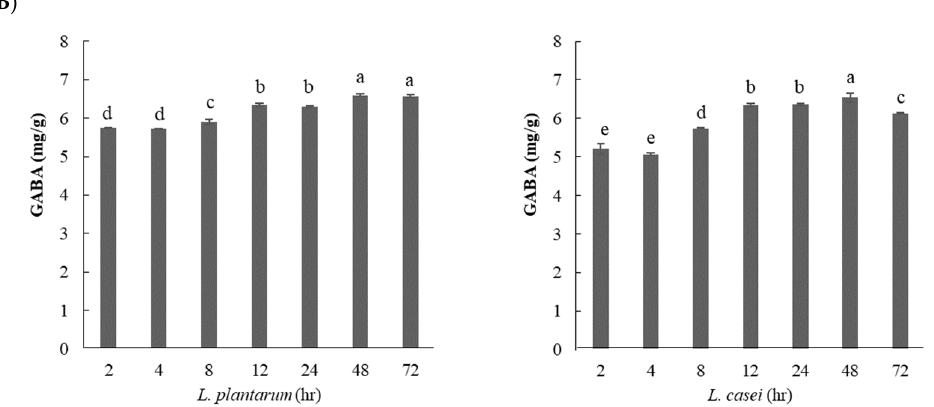
Figure 5. Glutamic acid ( A ) and GABA ( B ) contents of Oryza sativa extracts depending on the fermentation time. Each bar is the mean ± standard deviation of the results from three different analyses ( n = 3). Bars with different letters (a–e) indicate significant differences at p < 0.05 using Duncan’s multiple range test.